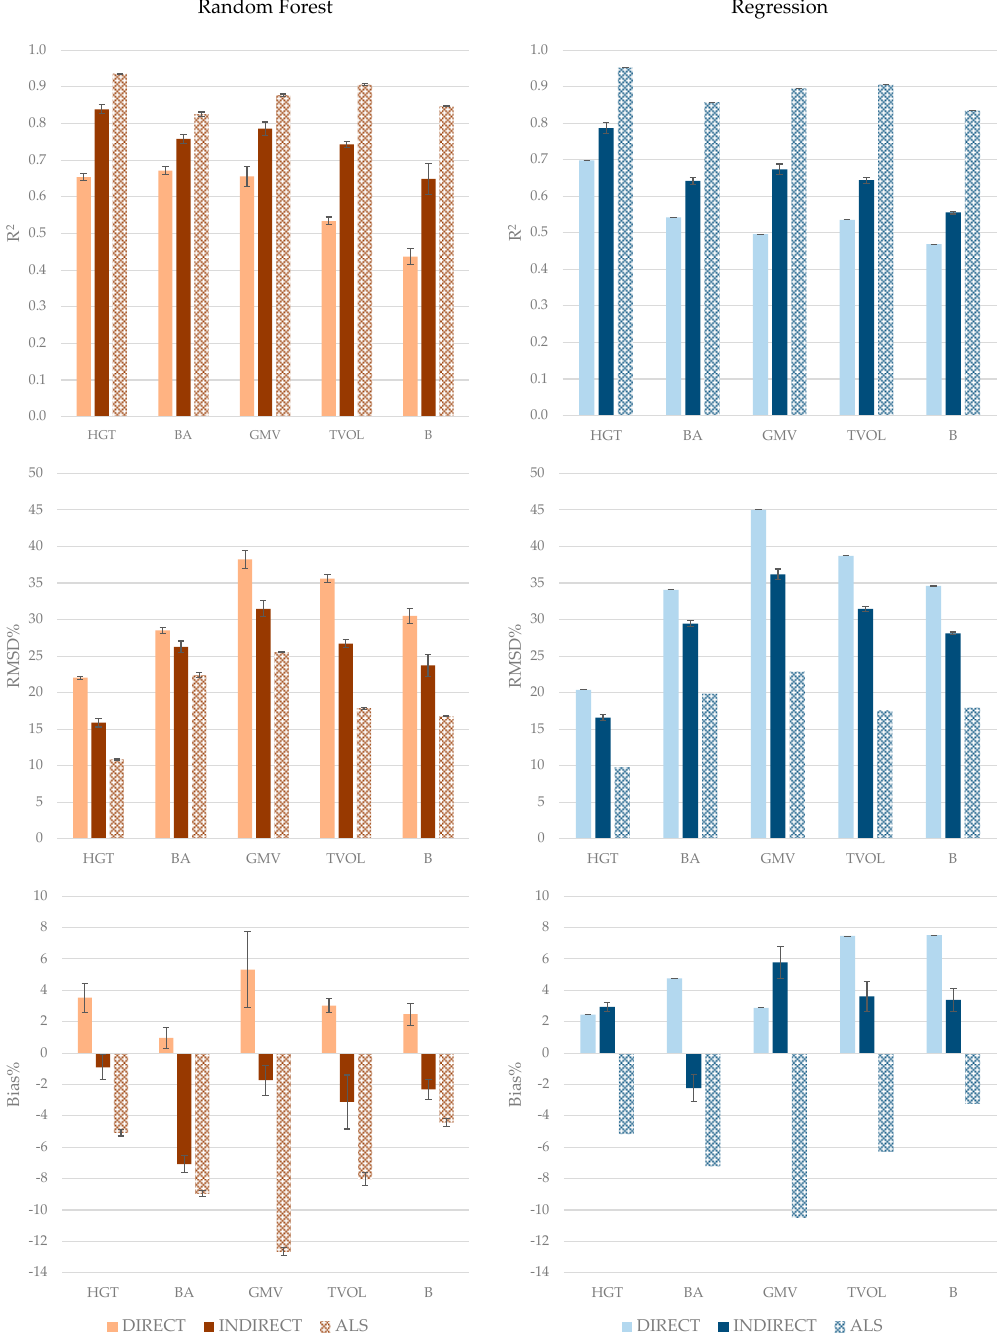
Figure 3. Independent evaluation of direct and indirect and modeling approaches. ALS model evaluation is shown for reference. Values presented are the average results of each approach implemented with five random seeds. Error bars represent ± 1 standard deviation. See Table 5 for evaluation of significant differences.